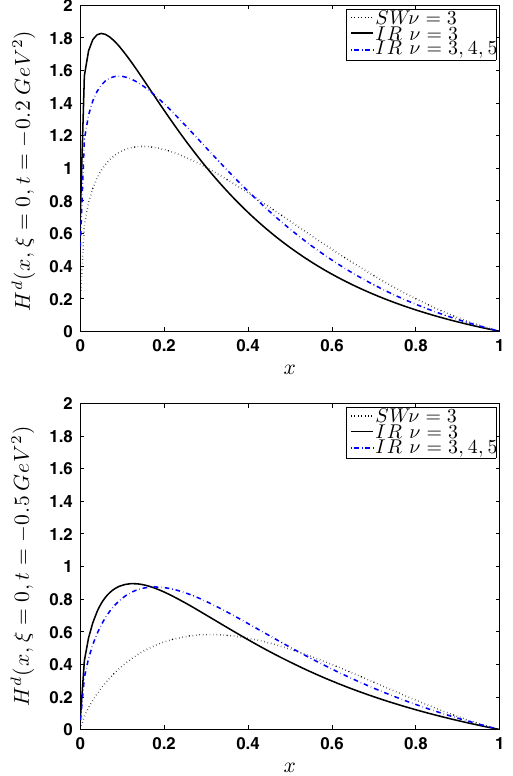
( x ,ξ = 0 , t = − 0 . 2GeV 2 ) Fig. 6 Upper panel The results for E u V predicted by the improved-IR model ( continuous line ) are compared withthesameresultsforathecorrespondingSWmodel( dotted )andthe LF model calculation of Ref. [58] ( dashed ). Only twist-3 contributions are included (cf. Sect. 3.1) and therefore the analysis is restricted to the valence sector. Lower panel As in the upper panel for t = − 0 . 5GeV